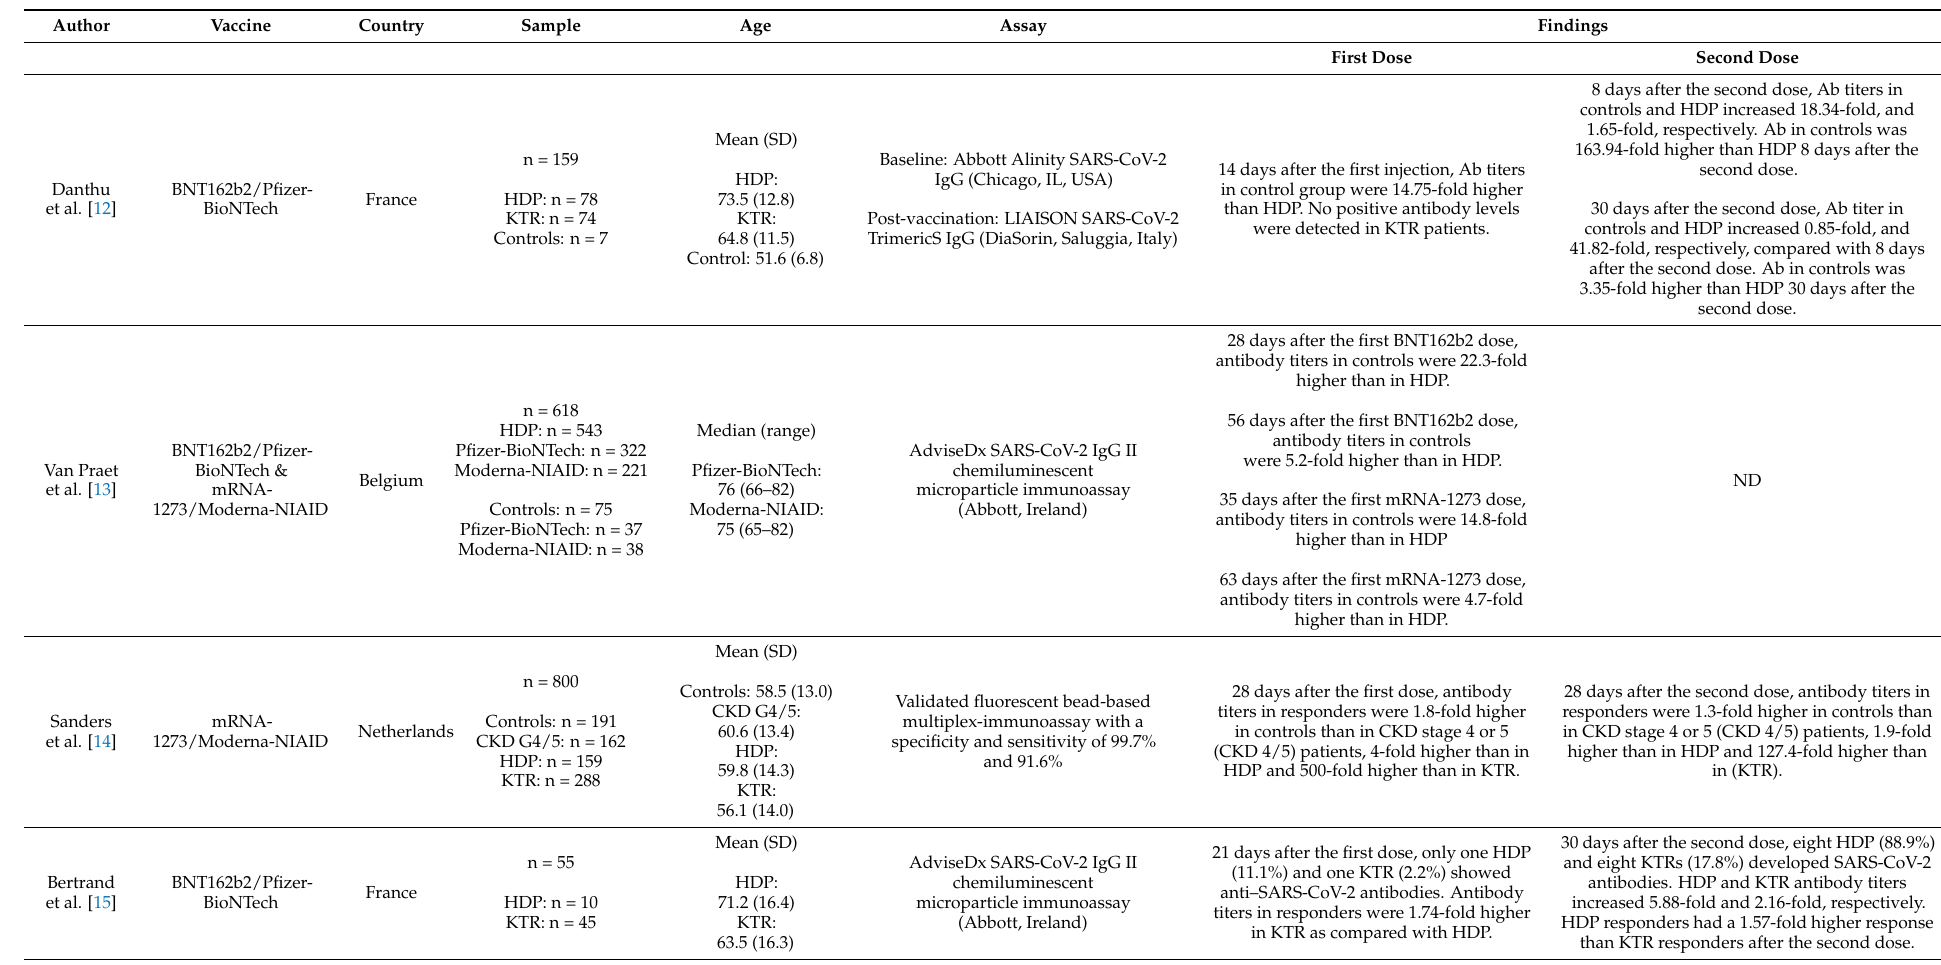
Table 2. Studies investigating the humoral response of hemodialysis patients post-COVID-19 vaccination with primary